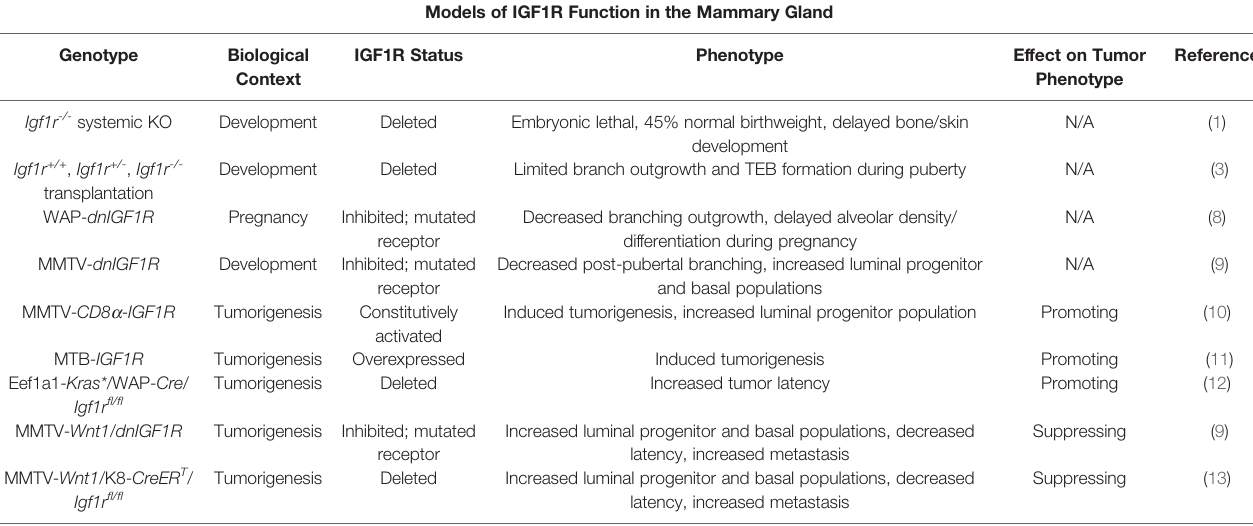
TABLE 1 | Summary of the mouse models used to study the function of IGF1R in development and tumorigenesis. Models of IGF1R Function in the Mammary